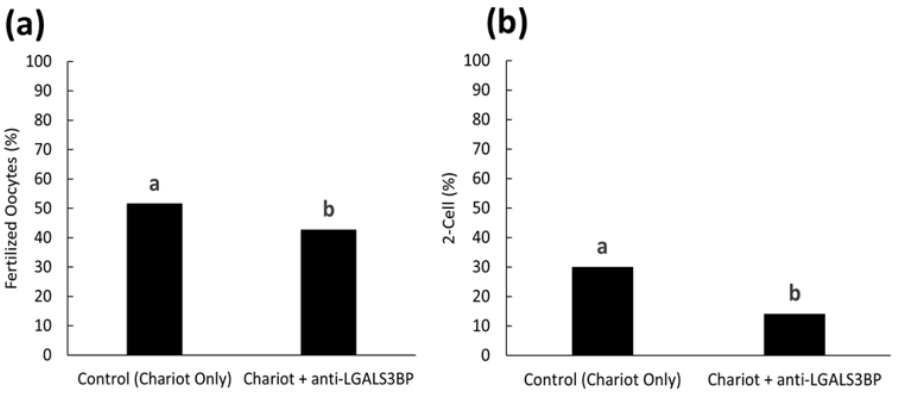
Figure 9. Proportions of ( a ) fertilized oocytes and ( b ) 2 ‐ cell embryos at 17 h post ‐ insemination with oocytes previously treated with Chariot reagent alone (control Chariot only) or with Chariot ‐ transfected EVs with anti ‐ LGALS3BP (Chariot + anti ‐ LGALS3BP). All oocytes were fertilized with untreated cauda spermatozoa. Bars with different letters significantly differ ( p < 0.05).